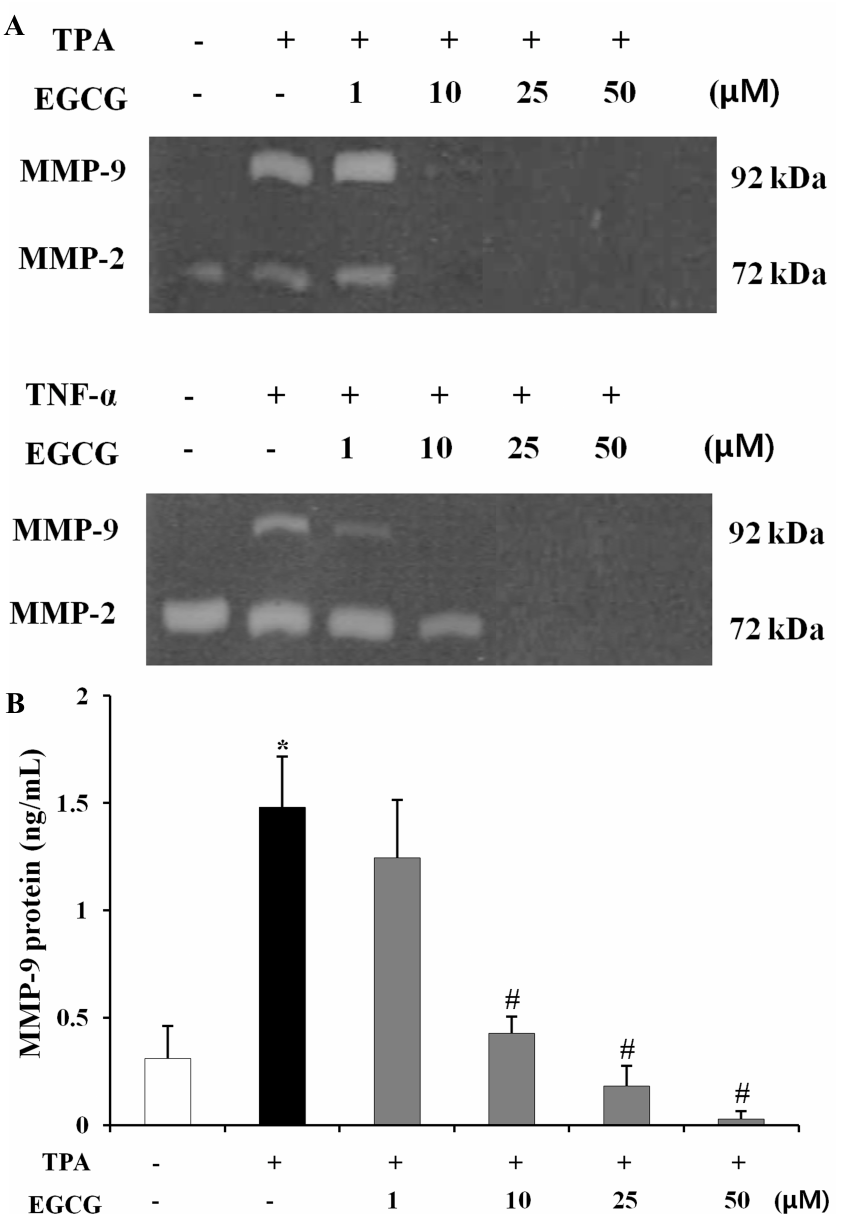
Figure 3. Characterization of MMP-9 in ARPE-19 cells treated with EGCG. ( A ) Gelatin zymography was performed using ARPE-19 cell lysates treated with 10 ng/mL TPA, 10 ng/mL TNF- α , and 1–50 μ M EGCG in serum-free medium for 24 h. Figures were selected as representative data from three independent experiments. The positions of MMP-2 and MMP-9 are indicated; ( B ) MMP-9 protein production at 24 h after TPA or EGCG treatment was determined by ELISA. The results are presented by mean ± SD (n = 9). * , p < 0.01 vs . TPA and EGCG untreated; #, p < 0.01 vs . TPA only; ( C ) MMP-9 mRNA expression levels at 24 h after TPA or EGCG treatment was analyzed by quantitative real-time PCR. The level of MMP-9 mRNA, corrected for differences in GAPDH levels between samples, are represented as fold induction of control and are presented by mean ± SD (n = 9). * , p < 0.01 vs . TPA and EGCG untreated; #, p < 0.01 vs . TPA